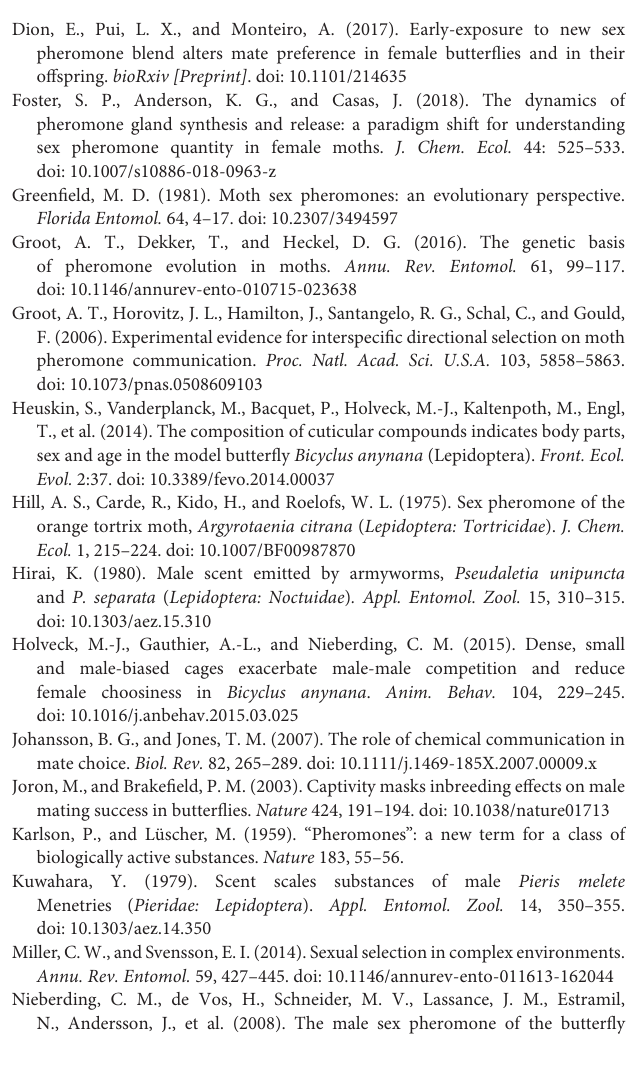
Supplementary Figure 1 | MSP1 (Left) and MSP3 (Right) headspace amounts (in ng/individual; Top) and solvent extract amounts (in ng/individual; Bottom) for each mating number (X-axis) and sex ratio